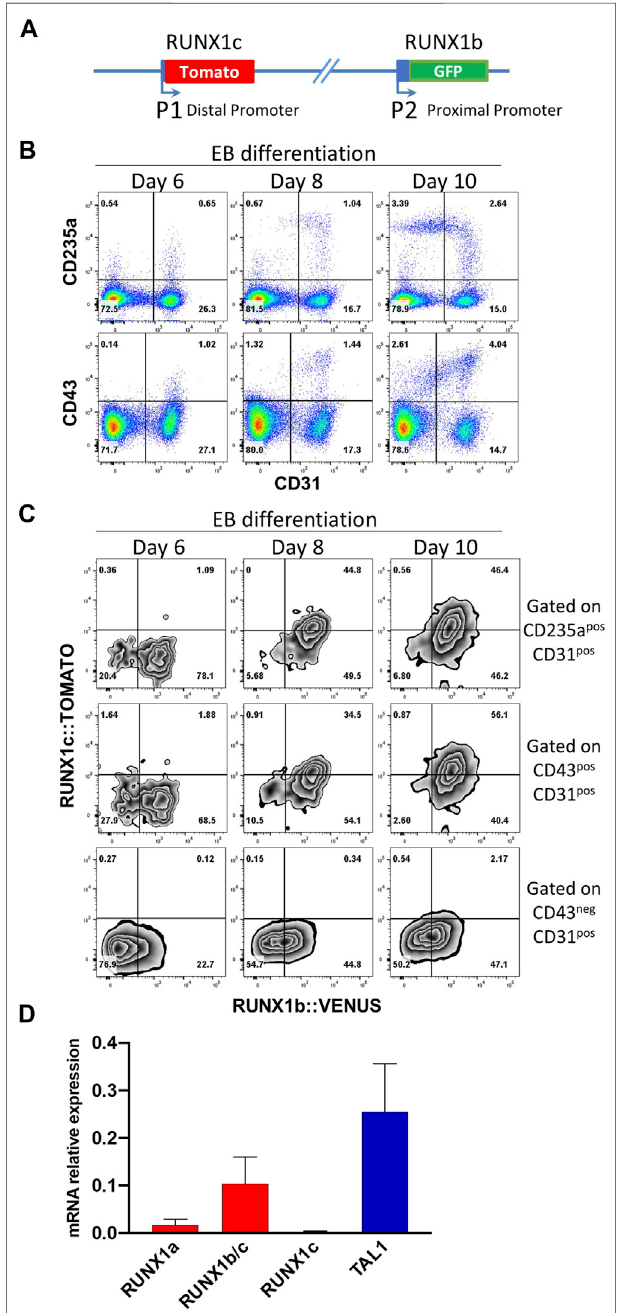
FIGURE 1 | RUNX1b and RUNX1c mark different stages of blood speci fi cation. (A) Schematic representation of the modi fi ed RUNX1 locus in human ESCs. (B) Flow cytometry analysis of embryoid body (EB) cells at day 6, 8 and 10 of differentiation for the indicated cell surface markers. (C) Flow cytometry analysis for RUNX1b:VENUS and RUNX1c:TOMATO in CD31 + CD43 − endothelial cells, CD31 + CD43 + and CD31 + CD235a + hematopoietic cells. (D) Expression of the indicated genes by qRT-PCR in CD31 + CD43 − cell populations sorted from day 6 EBs. Data are presented as mean +/ − SD of 3 independent experiments. All data are representative of at least 3 independent experiments. Similar expression pattern for RUNX1b: VENUS and RUNX1c:TOMATO were observed in two independent hESC